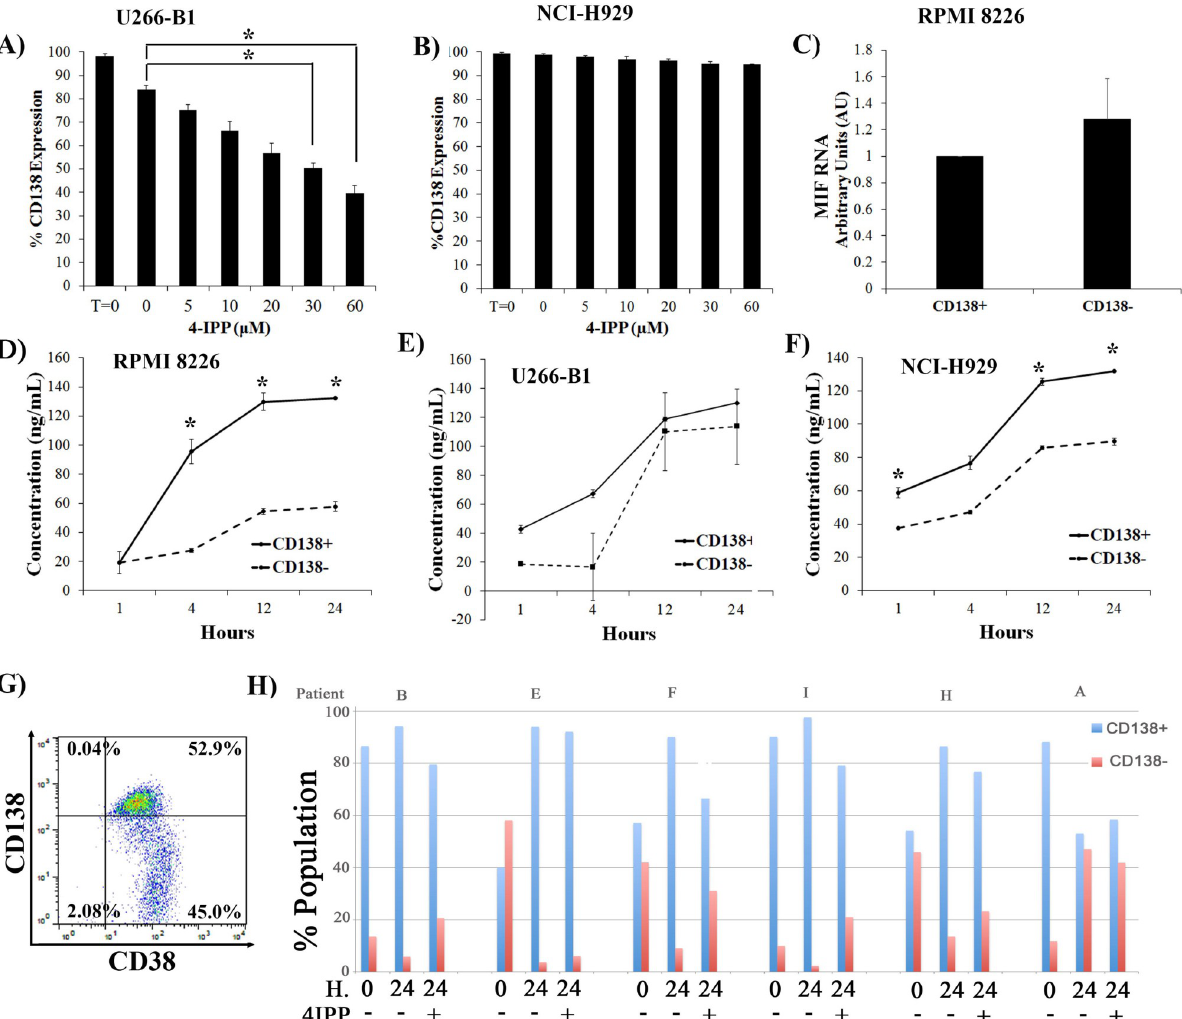
Fig 7. MIF-1 regulates differentiation in other cell lines and primary patient material. A) Sorted CD138+ U266 cells and B) NCI-H929 cells were plated and treated with increasing concentrations of 4-IPP for 24 h. Cells were then stained with CD138 and PI, and CD138 content of viable (PI negative) cells is plotted. T = 0 is CD138 status at time of plating (N = 3) � p < 0.05. C) Steady state MIF-1 levels of sorted CD138+ and CD138- RPMI 8226 cells as measured by RT-PCR. D, E, F) Sorted CD138+ (solid) and CD138- (dashed) cells from RPMI8226 (D), U266-B1 (E), and NCI-H929 (F) lines were plated and media harvested at 1, 4, 12, and 24 h. post plating for use in the MIF ELISA assay (N = 3). � p < 0.001 G) MM cells derived from human bone marrow aspirates from patient H, stained for CD138 and CD38 at time of harvest and analyzed by flow cytometry. Data is also plotted in panel H. H) BM derived MM cells were placed in culture +/- 4-IPP for 24 h., then were stained with CD38 and CD138. The CD138 status of the CD38 + gate is